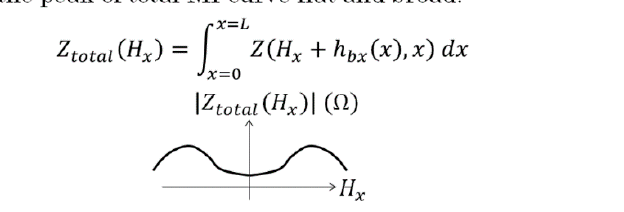
Figure 16. Schematic explanation of an effect of the distributed field on impedance integral [21].